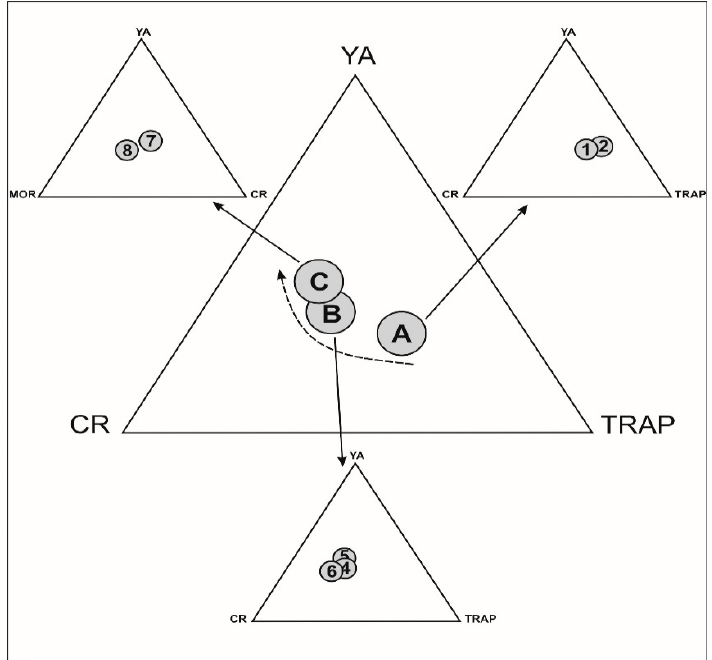
Figure 6. Location of composition points of the Archaean complexes in the Kola region on diagrams showing relative proximity to certain geodynamic regimes. Notations are specified in Table 1.